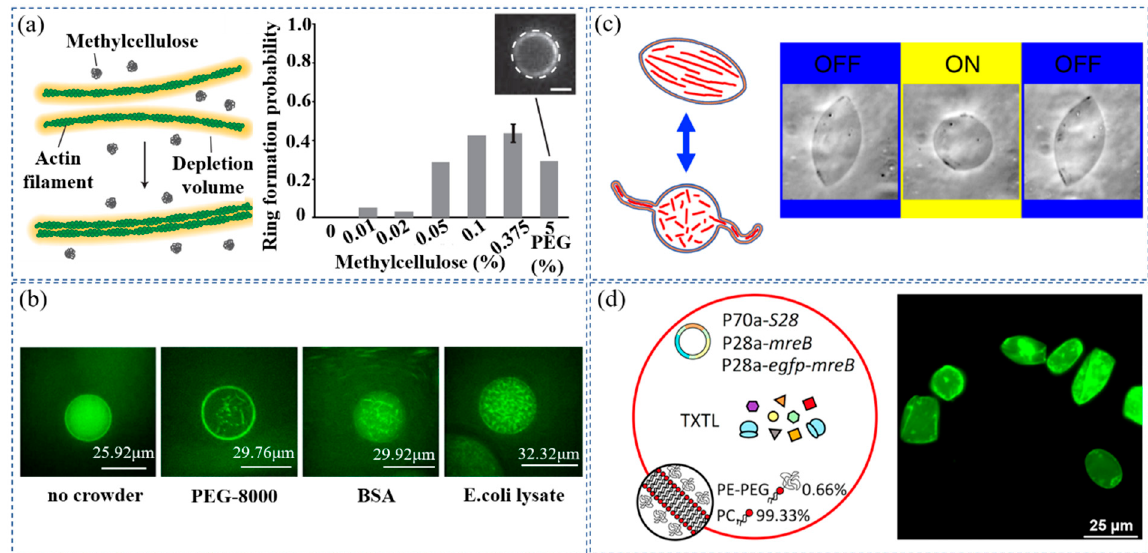
Figure 2. ( a ) The crowding effect of macromolecules promoted actin-ring formation at the equatorial plane of the droplet. Reprinted with permission from Ref. [36] 2015, Springer Nature. ( b ) FtsZ bundle formation with no crowder, polymeric crowder PEG-8000, protein crowder BSA, and E. coli lysate. Reprinted with permission from Ref. [37] 2015, American Chemical Society. ( c ) Repeated deformation of spindle-shaped liposomes encapsulating high-concentration actin. Reprinted with permission from Ref. [38] 2018, Springer Nature. ( d ) MreB produced by cell-free expression deformed liposomes with membranes composed of PC and PE-PEG. Reprinted with permission from Ref. [39] 2020, American Chemical Society.